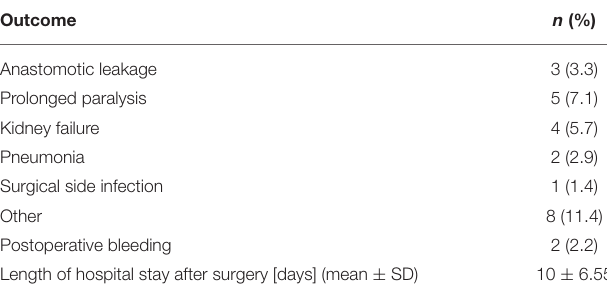
TABLE 3 | Outcome after intraoperative colonic irrigation ( n =